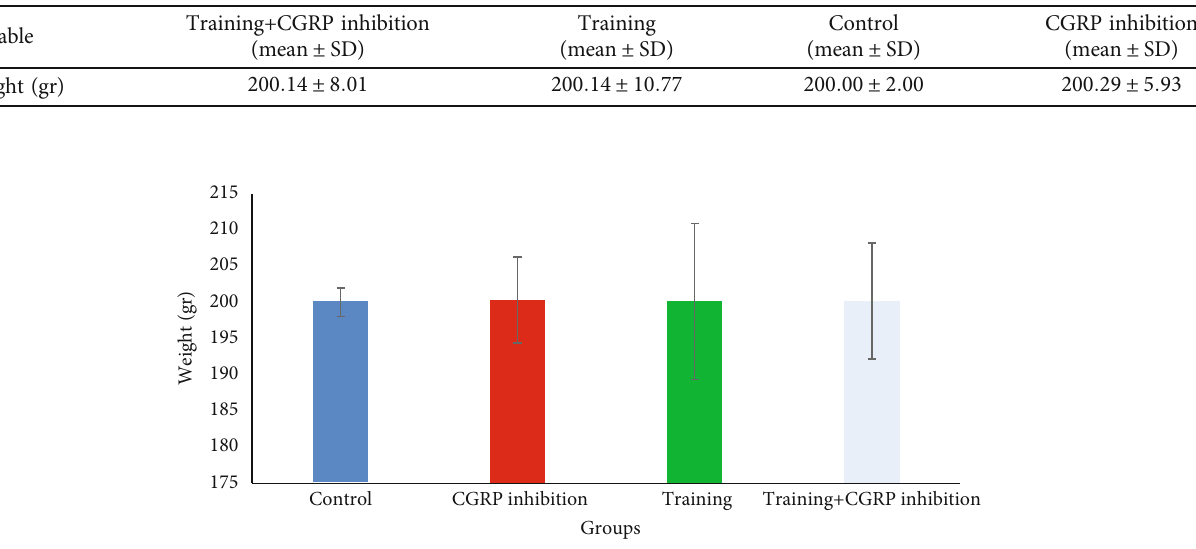
Table 4: Means and standard deviations of rats ’ weights in study groups.